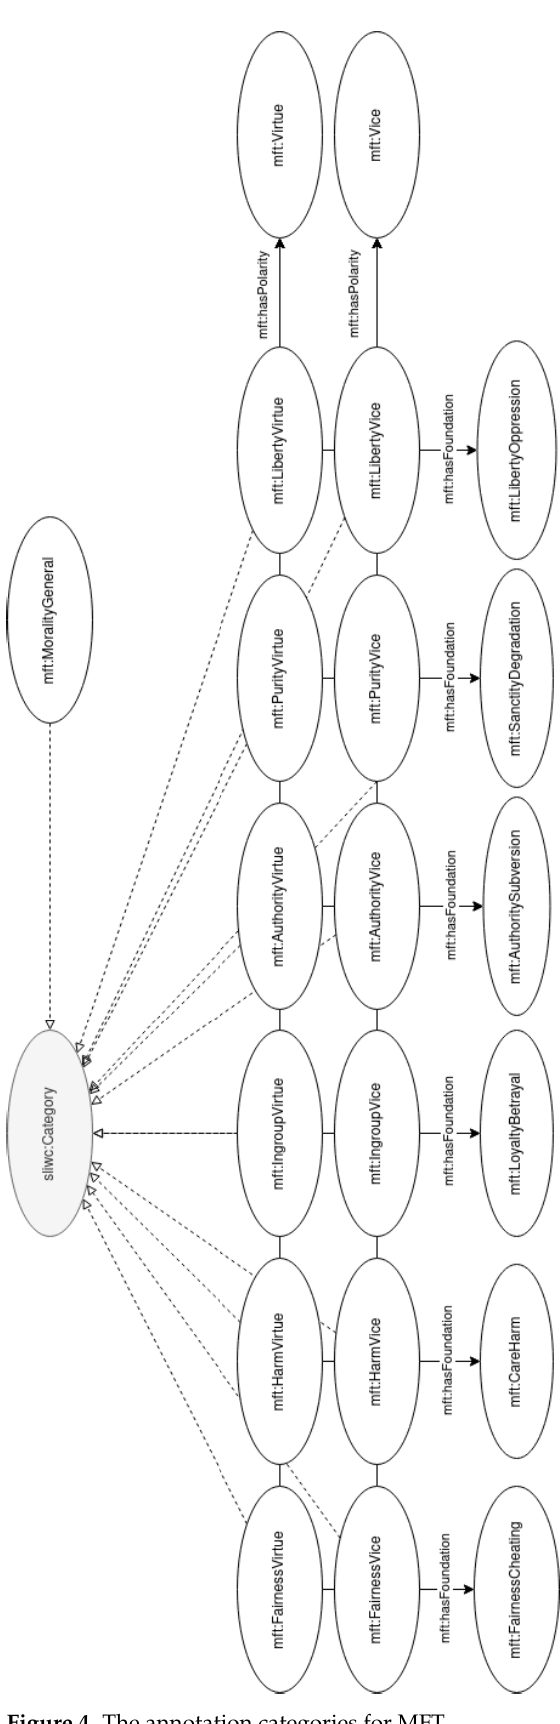
Figure 4. The annotation categories for